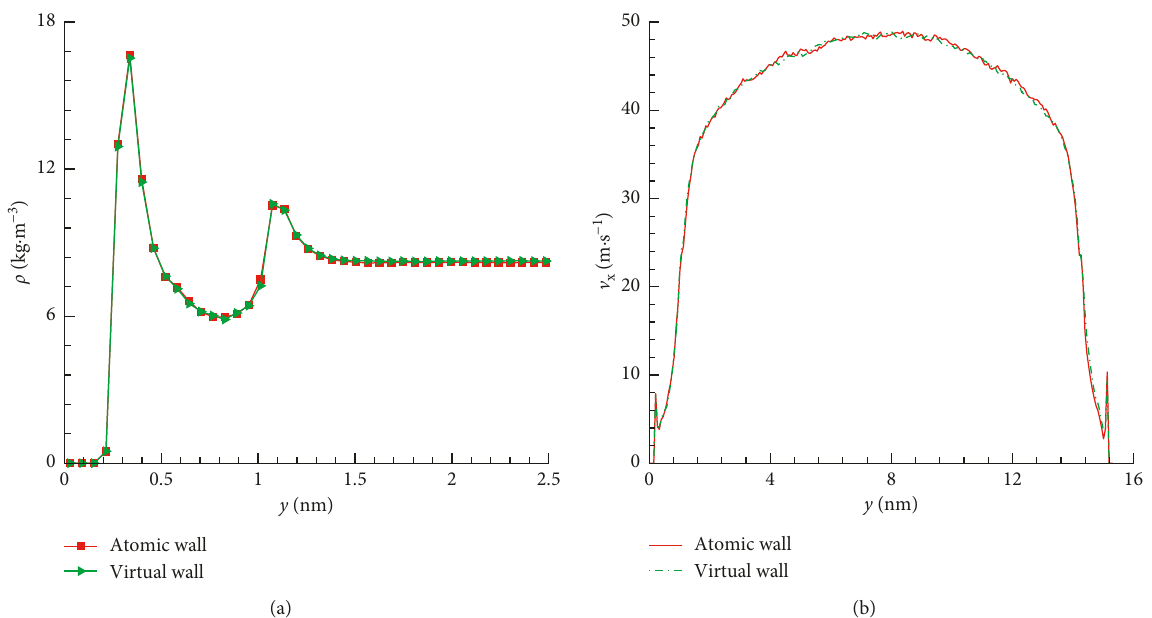
Figure 3: Comparisons between the atomic- and virtual-wall models for the rough wall: (a) density profile; (b) velocity profile.